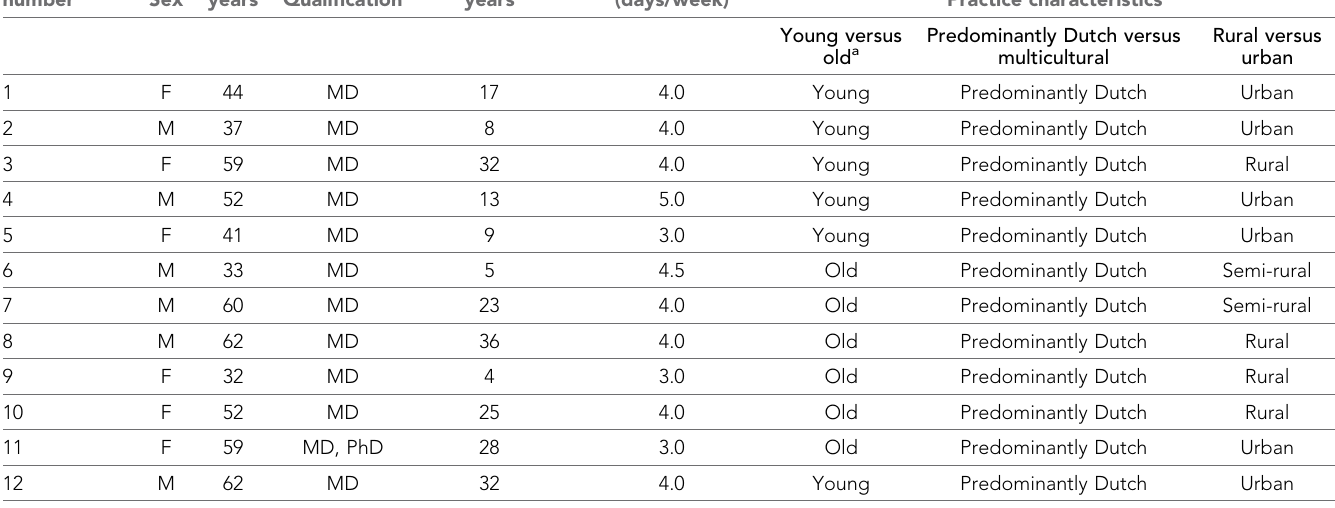
Table 1. Characteristics of